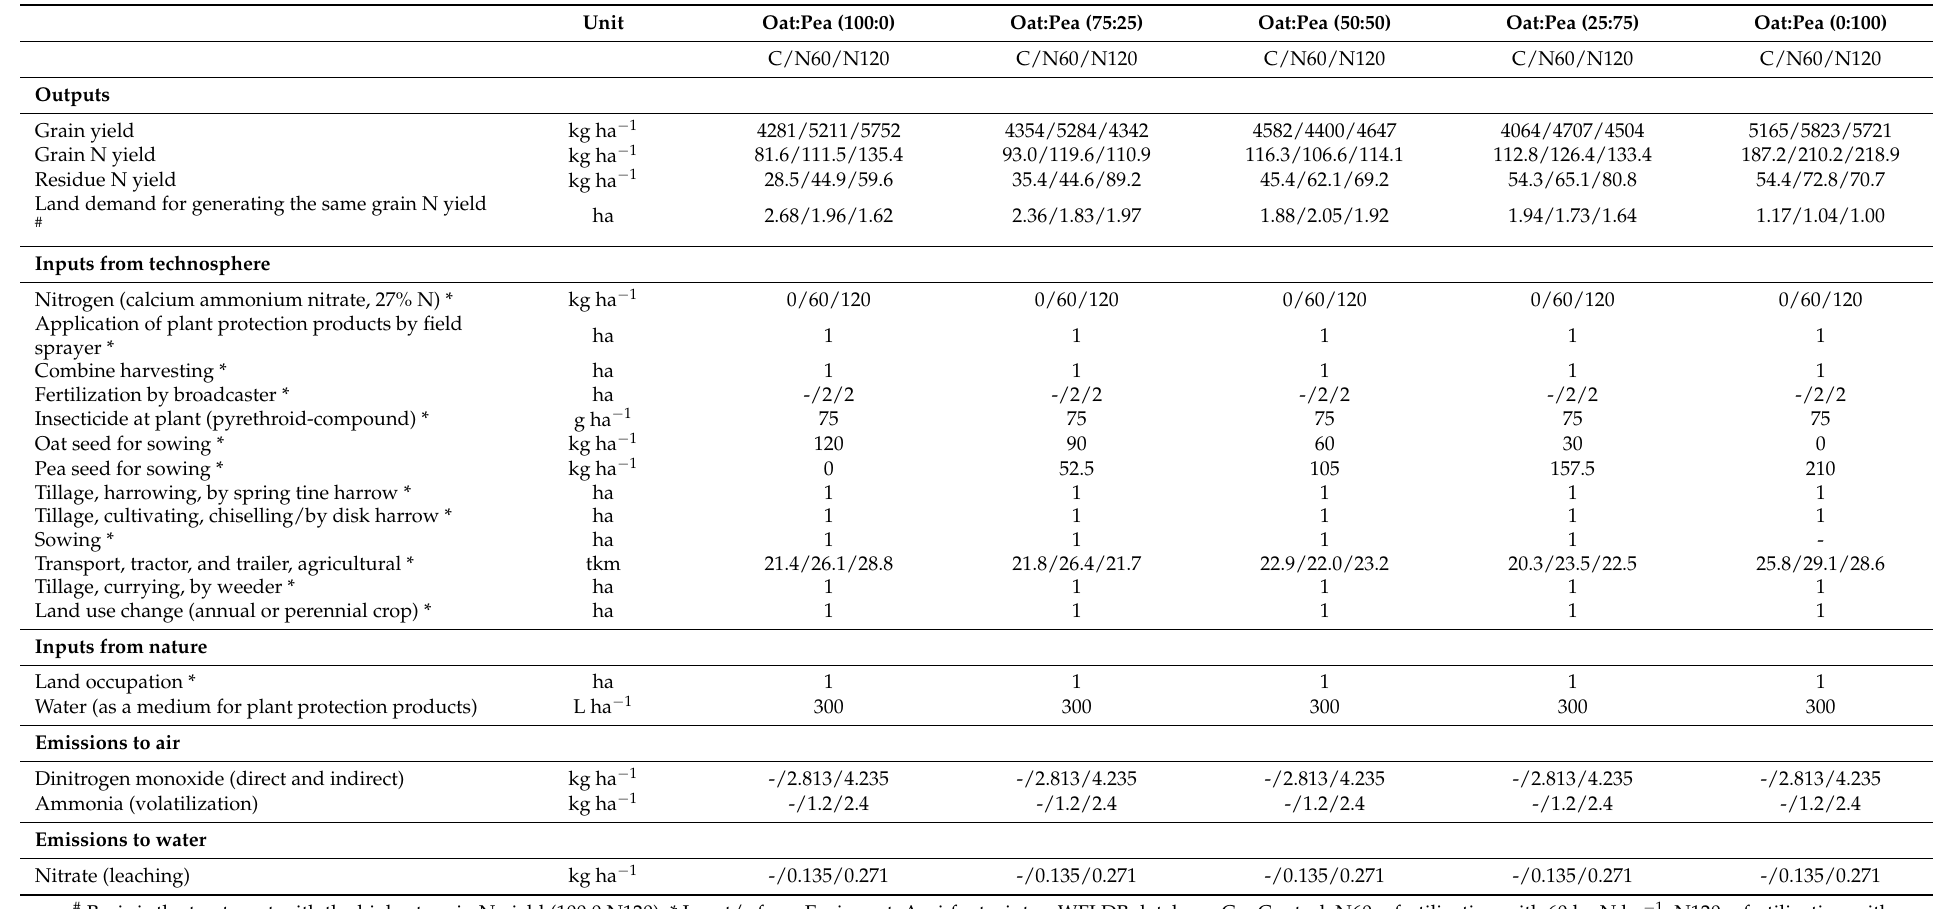
Table 1. Inventory table: inputs and outputs of the life